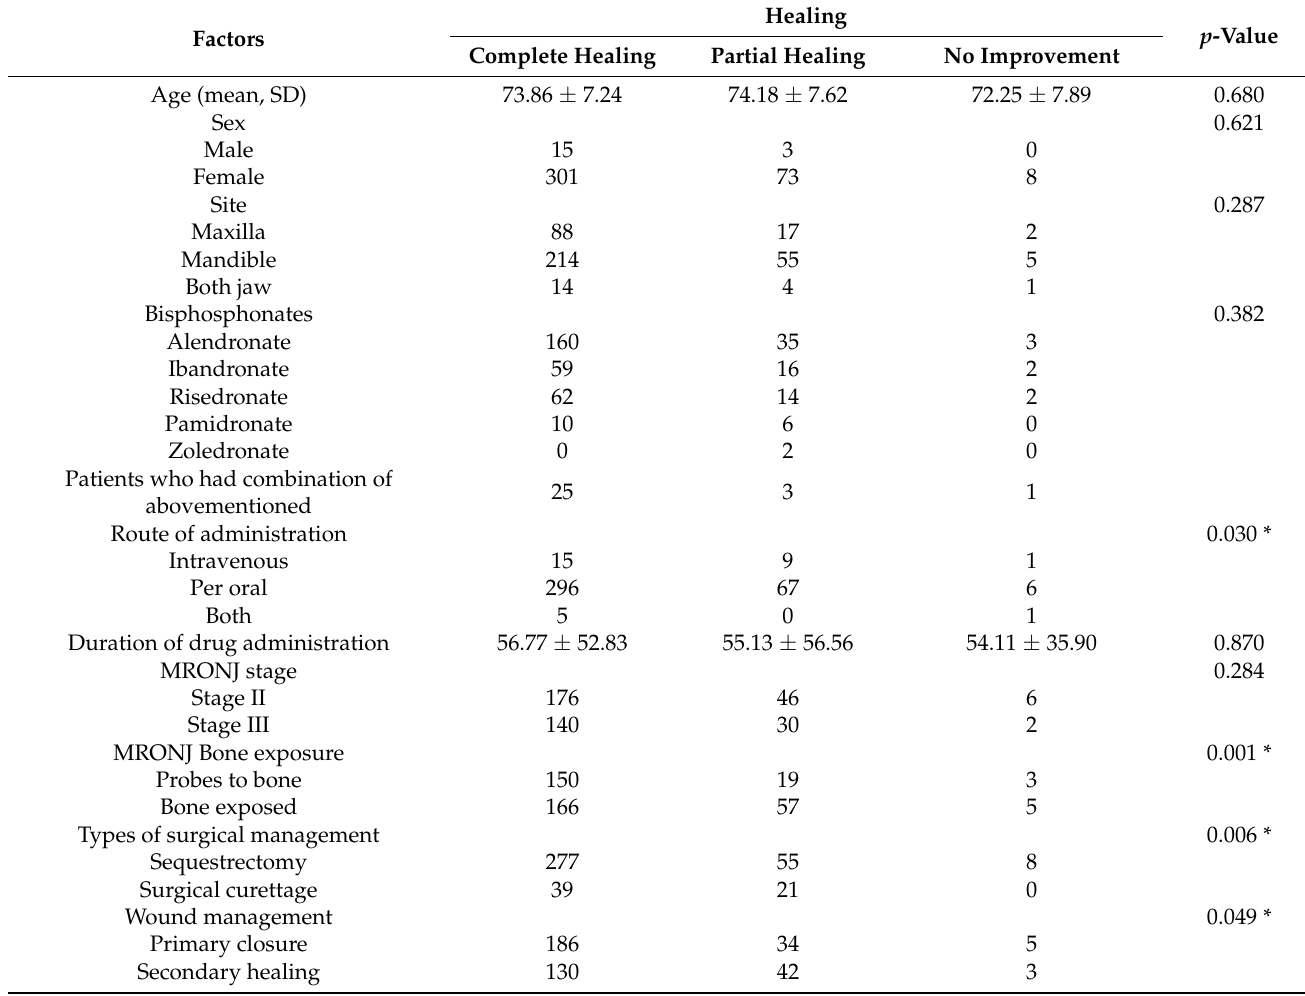
Table 2. Description of treatment outcomes and Spearman’s rho correlation analysis of the factors and healing. Factors